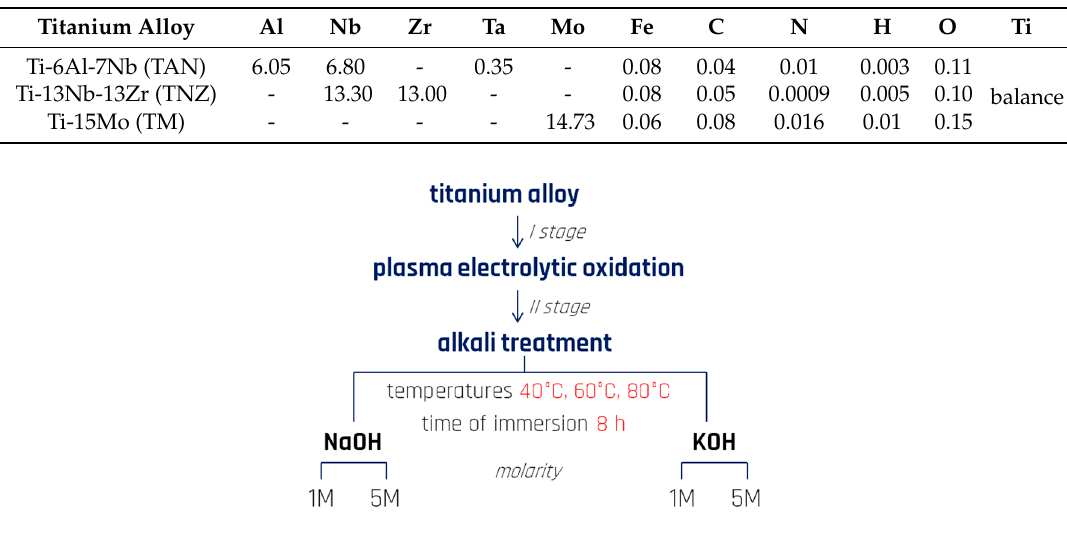
Figure 1. Scheme of titanium alloy surface treatment.